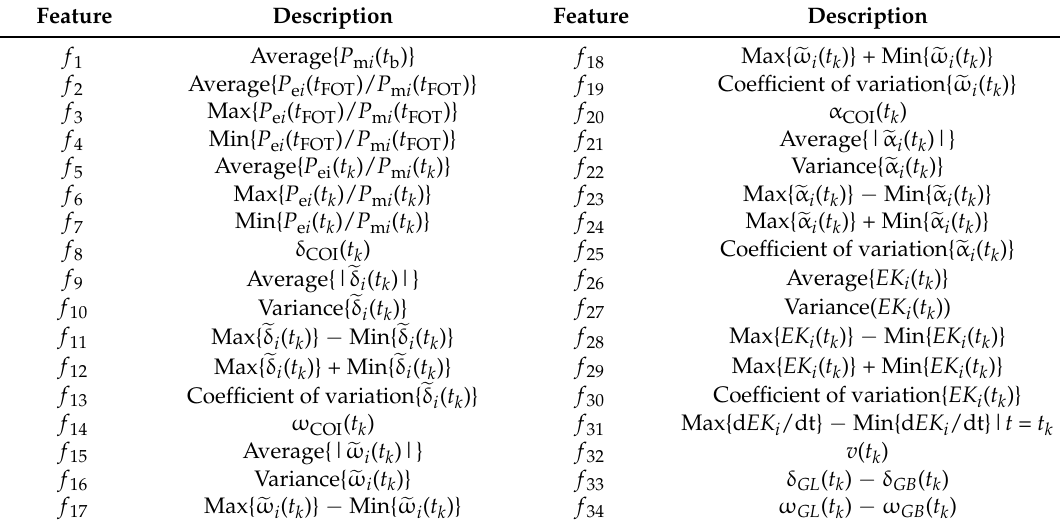
Table 1. Construction of the input features. COI: centre of inertia.